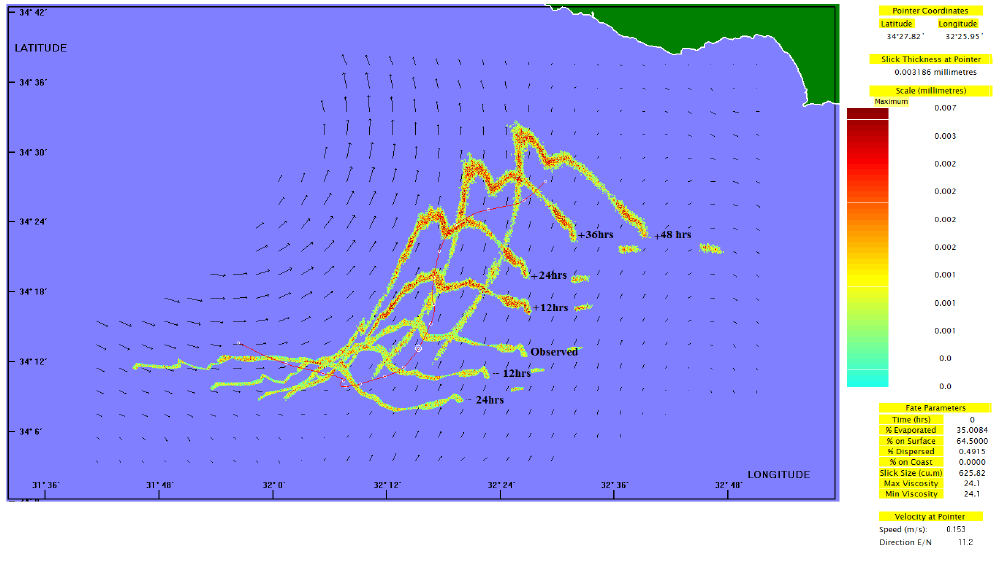
Fig. 6. Configuration of slick at intervals of 12h corresponding to the observation in Fig. 2b. The third slick from the left is the observed image. The hindcast is for 24h and the forecast for